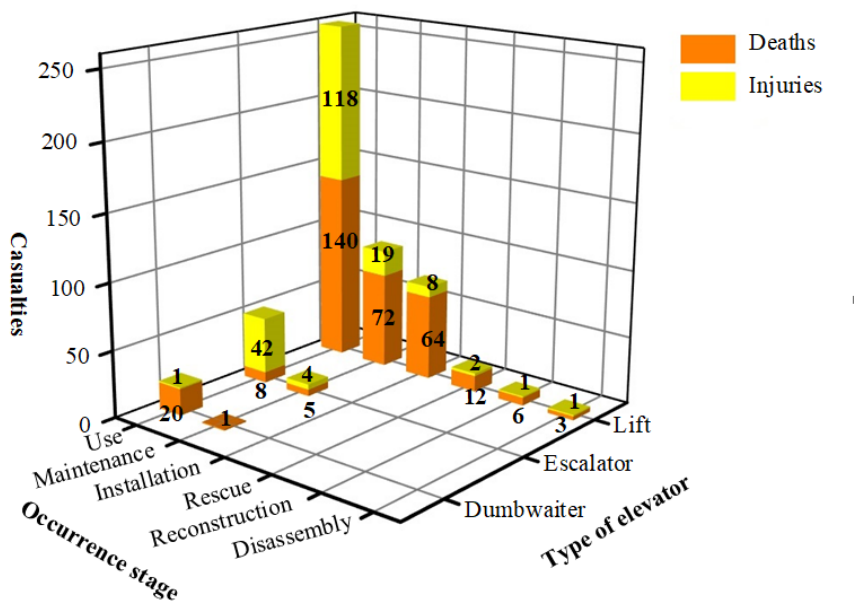
Fig. 4 Statistics of casualties due to accident occurrence